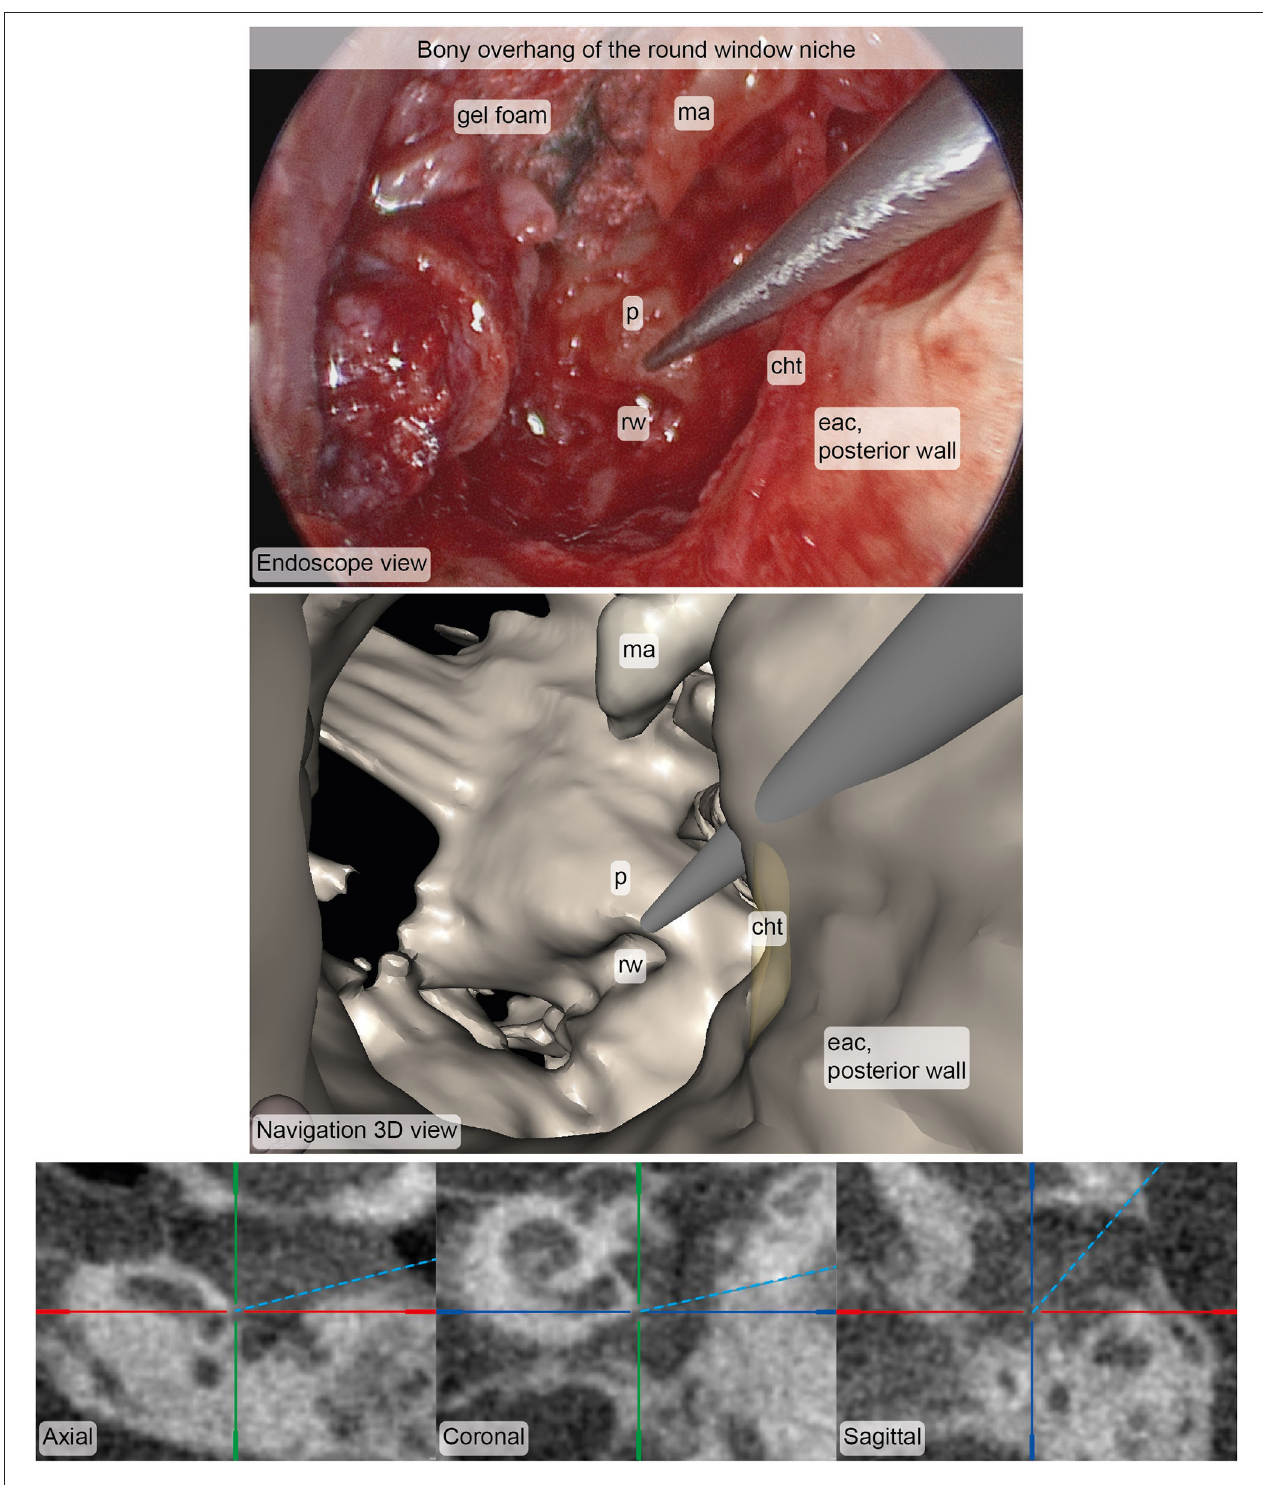
FIGURE 6 | Example of corresponding images from the endoscope (top) and the stereotactic image-guidance system (bottom) depicting the pointer pose at the bony overhang of the round window niche. The image pair was rated in terms of accuracy (median: 4, interquartile range: 4–5, N = 5) and usefulness (median: 4, interquartile range: 4–5, N = 5). Inspection of and zooming into the individual MPR and 3D viewer panels were possible during rating. cht, chorda tympani; eac, external auditory canal; ma, malleus; p, promontory; rw, round window.